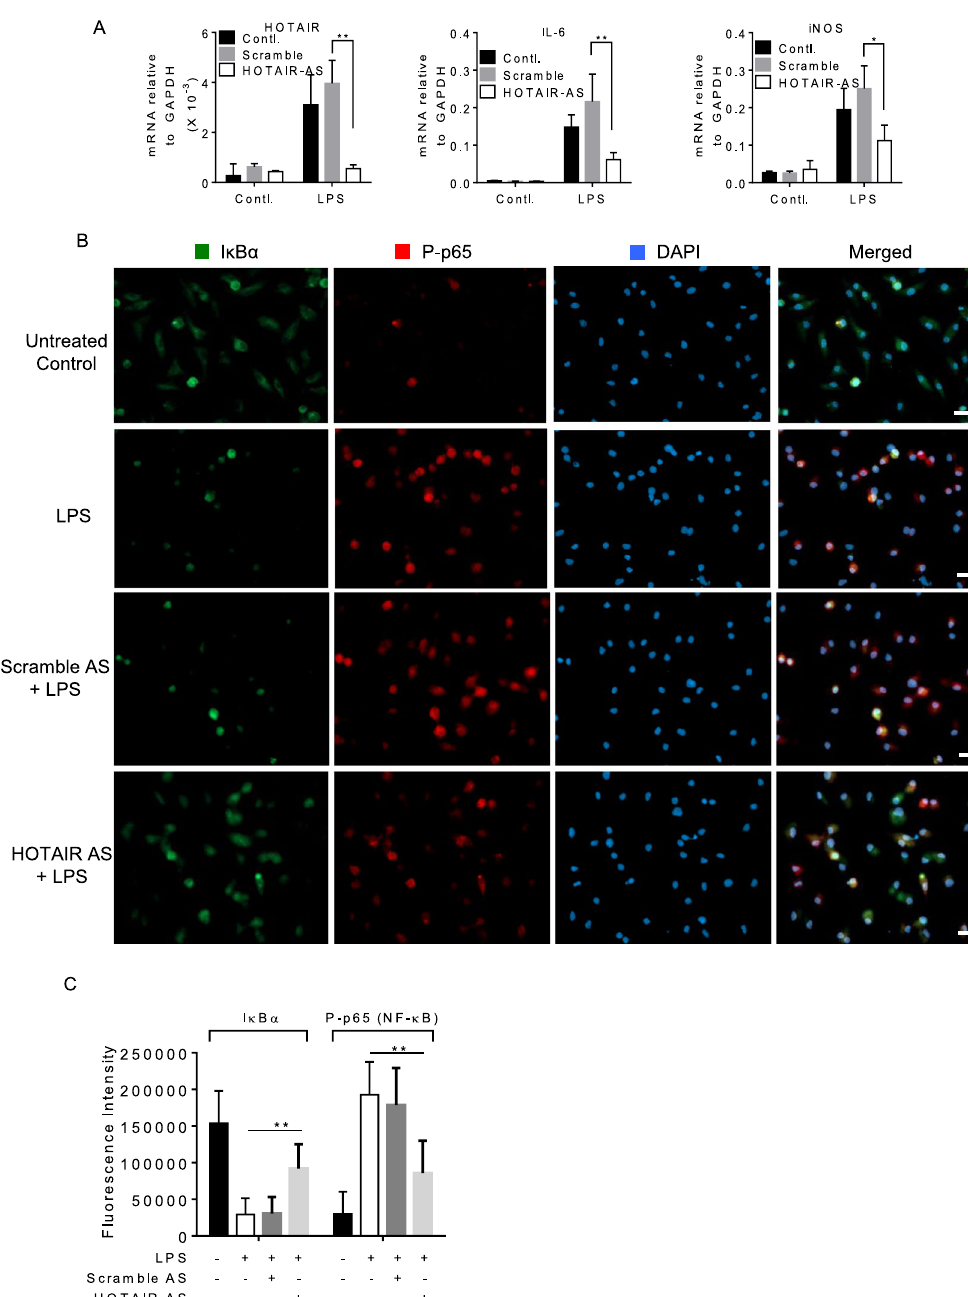
demonstrated that HOTAIR expression is induced upon LPS-stimulation in primary macrophages and it is required for the LPS-induced expression of IL-6 and iNOS. HOTAIR-knocked down and LPS-treated BMDM cells were also analyzed by immunostaining to understand the function of HOTAIR in NF- κ B activation using similar experiments outlined in Fig. 5. Interestingly, we found